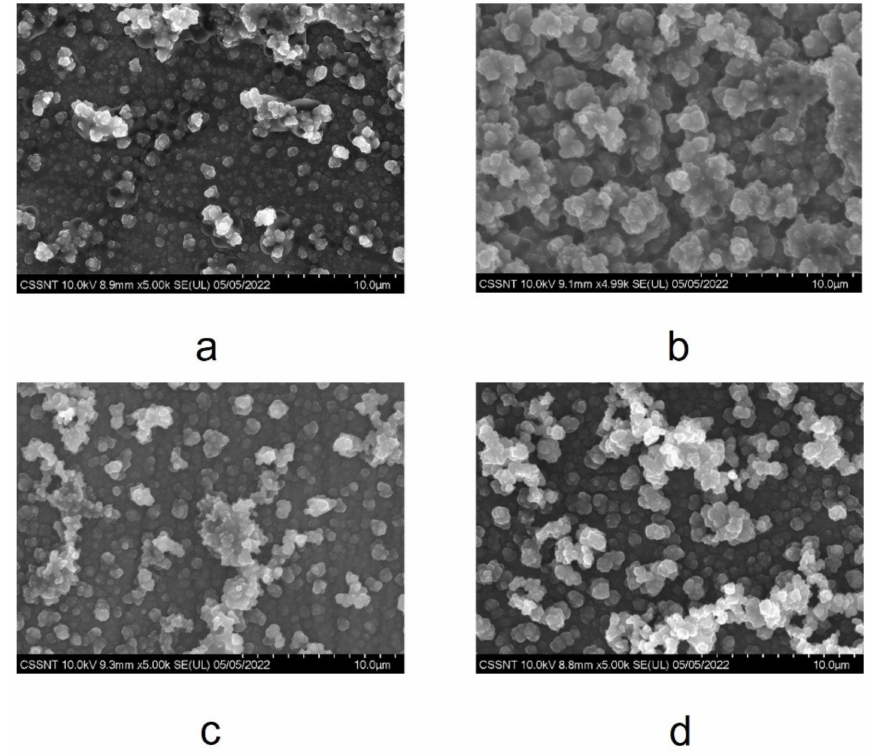
Figure 4. SEM micrographs at the same magnifications (5 kx) for: ( a ) PPy on WBC; ( b ) PPy-Indo on WBC; ( c ) PPy on Hera and ( d ) PPy-Indo on Hera types of